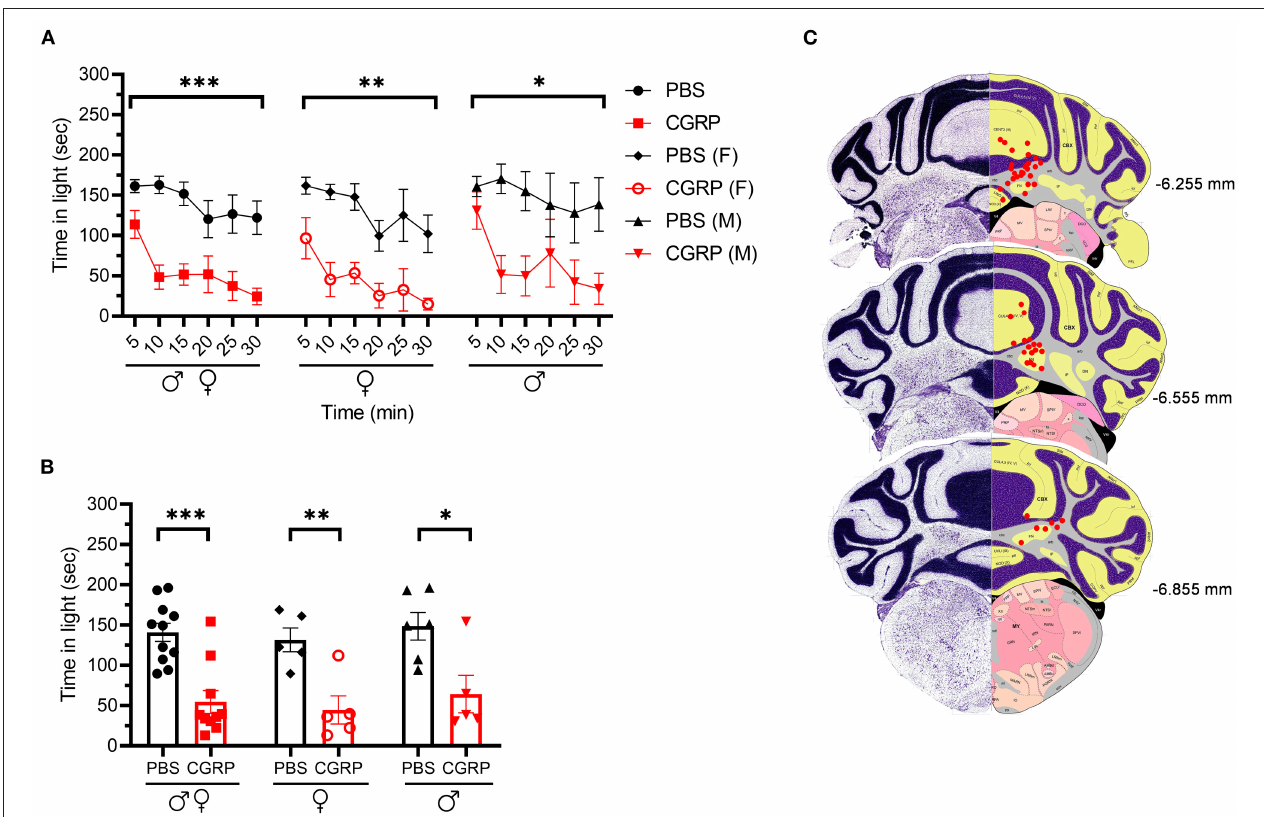
FIGURE 1 | Injection of CGRP into the MN induced light-aversive behavior under dim light. (A) Time in light every 5-min block during 30-min light/dark assay at 55 lux following injection of PBS ( n = 11; F: n = 5; M; n = 6) or CGRP (1 µ g /200 nl; n = 10; F: n = 5; M: n = 5) into the right MN of C57BL/6J mice via cannulas. Time in light for all mice (left), female mice (middle), and male mice (right). Data are from two independent experiments. All mice in A are further analyzed in B. (B) Mean time in light per 5-min block for individual mice. (C) Schematic of positions of injection cannula tips superimposed on Allen Mouse Brain Atlas coronal images. Numbers indicate the distance from bregma in the anteroposterior plane. Data are the mean ± SEM. Statistics are described in Supplementary Table 1 . * p ≤ 0.05, ** p ≤ 0.01, *** p ≤